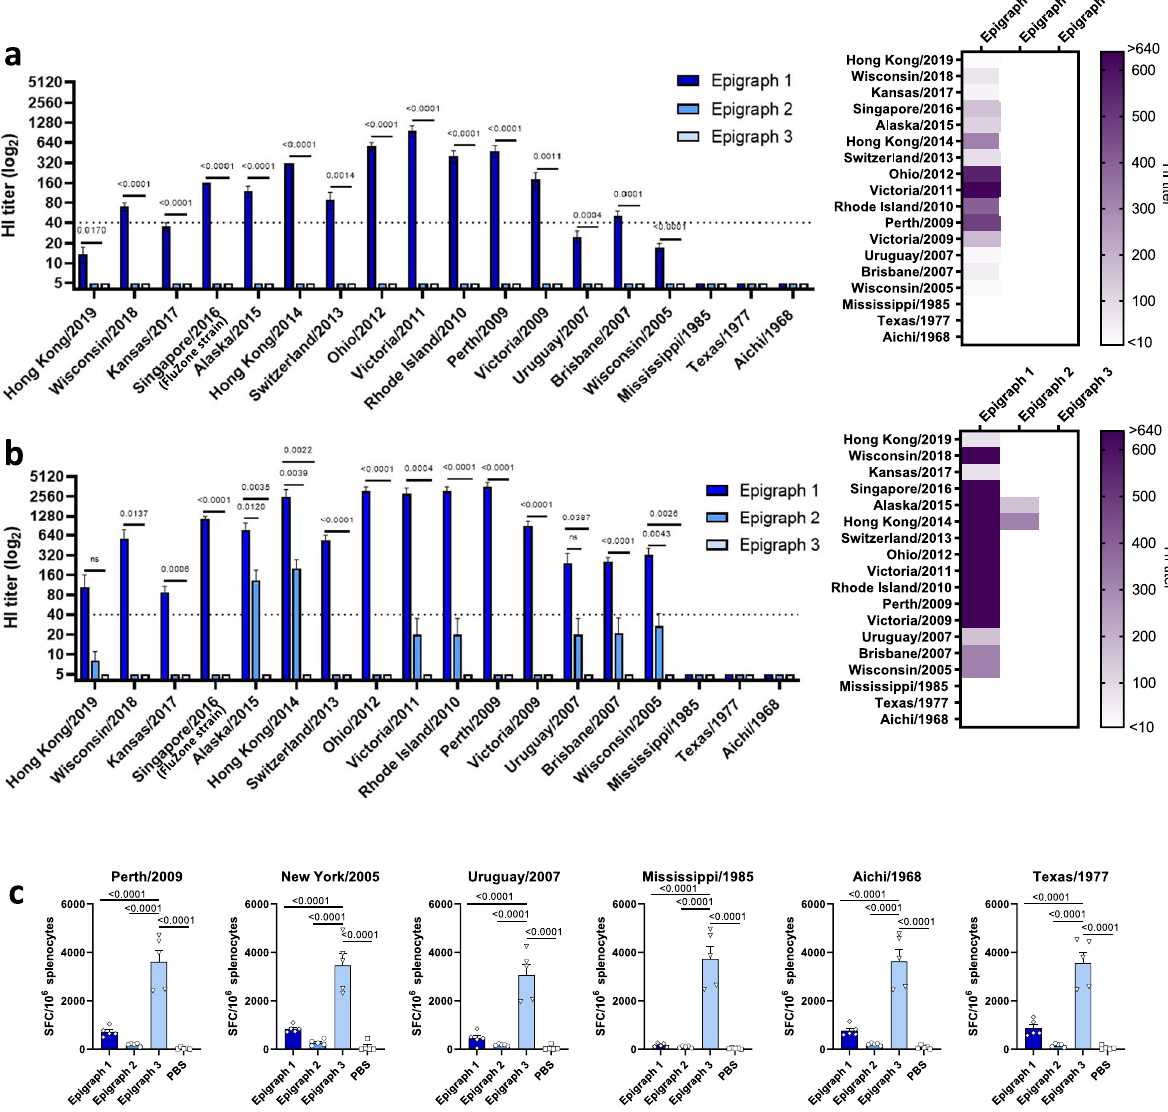
Fig. 6 Contribution of each individual Epigraph immunogen towards the cross-reactive antibody and T-cell responses. To examine the contribution of each individual Epigraph immunogen, BALB/c mice ( n = 5) were immunized with 3.3 × 10 9 vp of HAdV-5-Epigraph 1, 2, or 3 individually. Antibody responses were measured using a HI assay against the 18 H3 representative strains for both a single immunization ( a ) or after boosting ( b ). A heat map of these HI titers was constructed to further visualize the total cross-reactive antibody response of each vaccine. c The total T-cell response after boosting was determined using an interferon IFN- γ ELISpot with peptide libraries for six H3 strains. T-cell responses are reported as spot-forming cells (SFC) per million splenocytes ( n = 5; one-way ANOVA with Tukey multiple comparisons). Data are presented as the mean with standard error